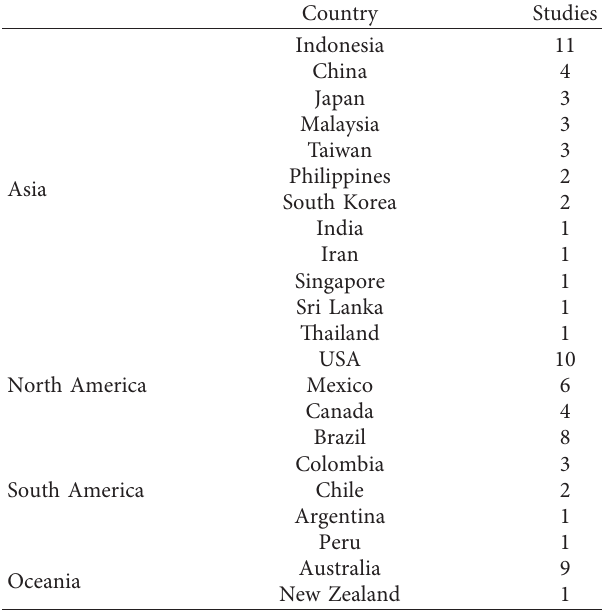
Table 5: Uses of standardized questionnaires by country in Asia, North America, South America, and Oceania. Country